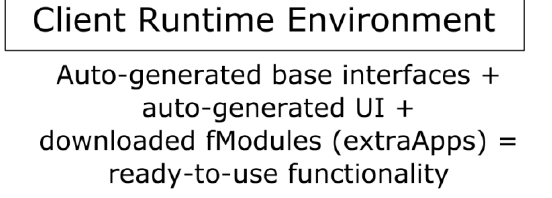
Figure 6. Processes on client side, in the case of desktop